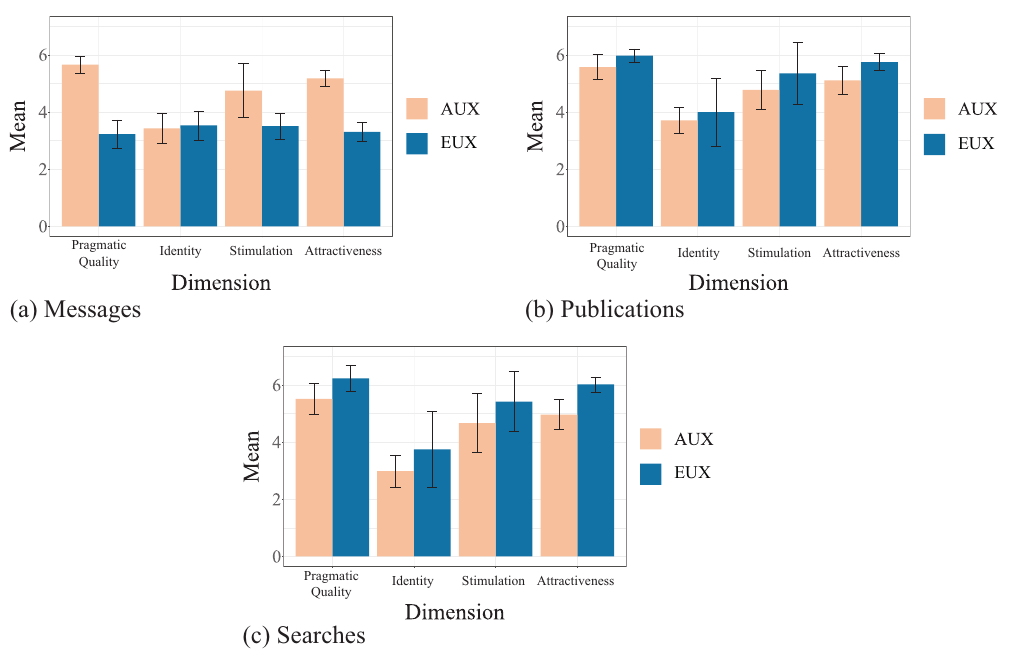
Figure 4. AttrakDiff results for messages ( a ), publications ( b ), and searches ( c ).